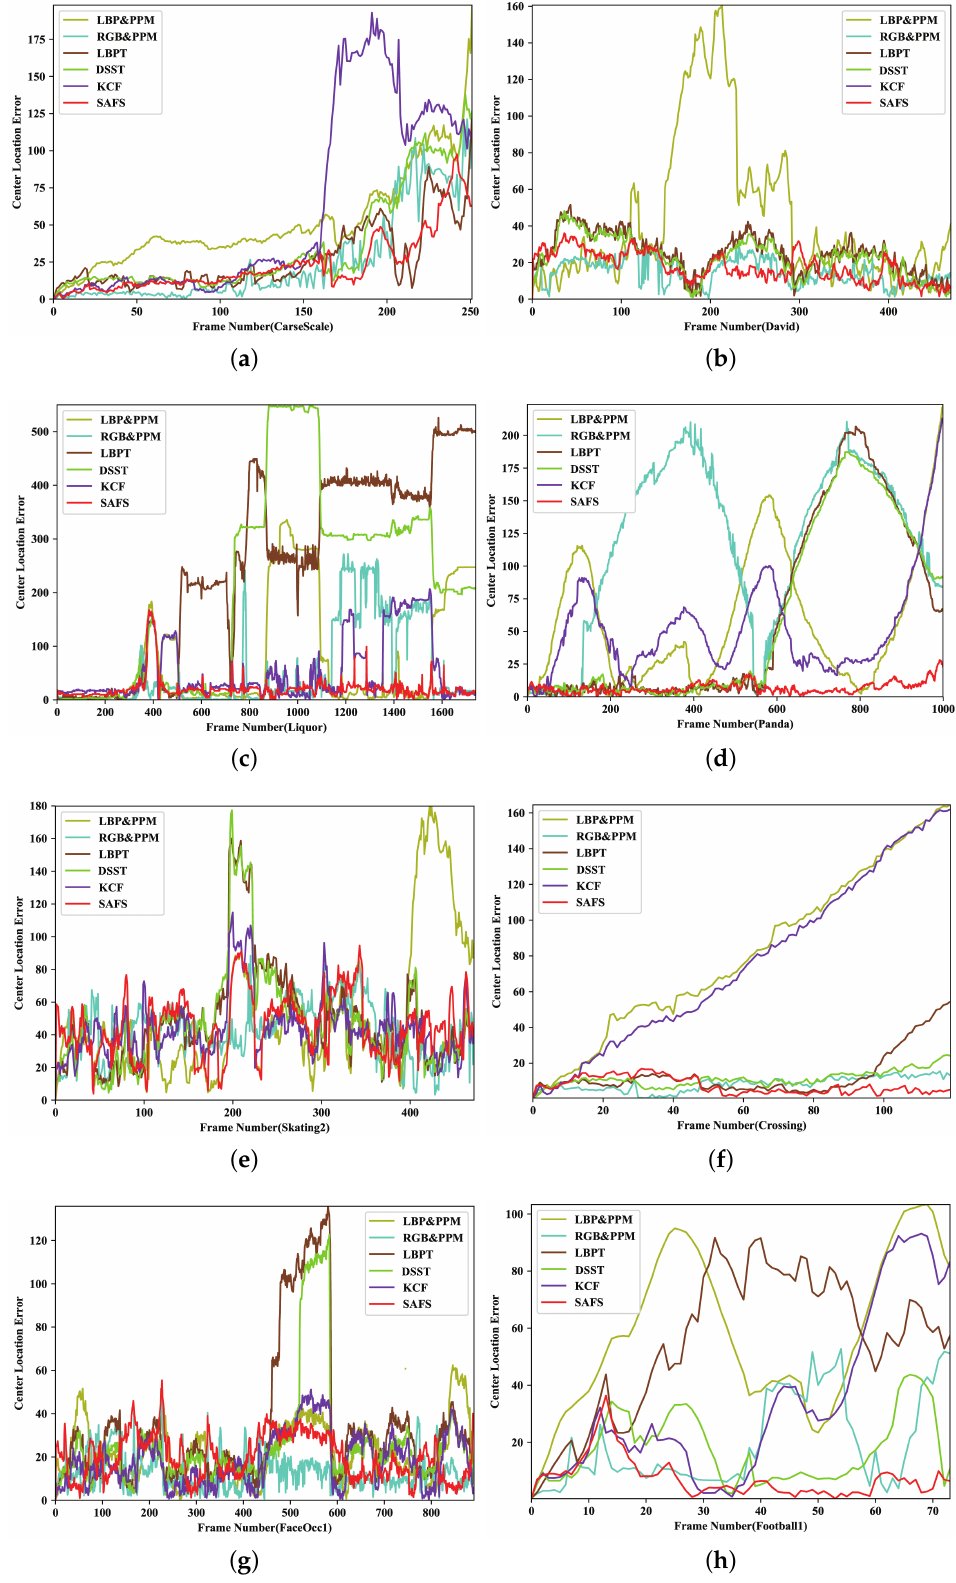
Figure 4. The experimental results of comparing the CLE (in pixel) frame by frame in eight sequences. Our SAFS algorithm can track the object robustly and accurately. ( a ) CarScale; ( b ) David; ( c ) Liquor; ( d ) Panda; ( e ) Skating2; ( f ) Crossing; ( g ) FaceOcc1; ( h )